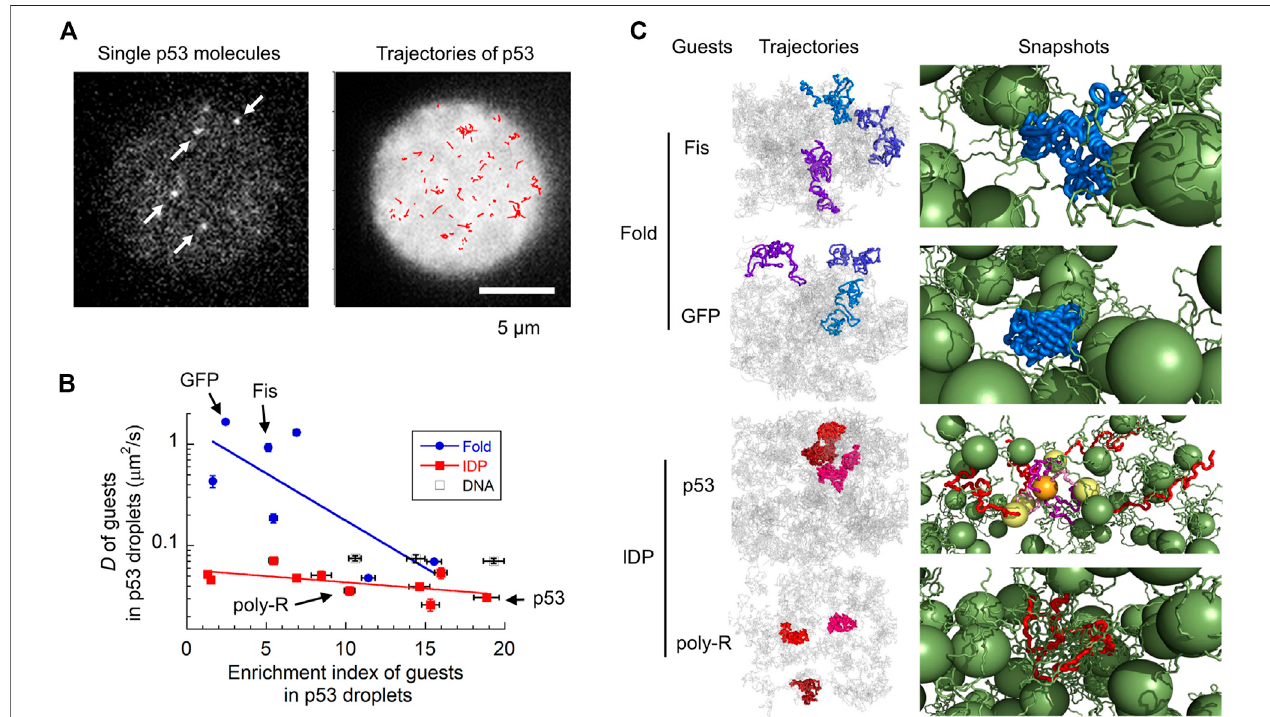
FIGURE 2 | Molecular characterization of guest proteins in p53 droplets. (A) Snapshots and trajectories of guest p53 molecules in p53 droplets detected via SM fl uorescence microscopy. The trajectories of molecules (red) in the right panel are plotted in adroplet(white). (B) Uptakepreference (enrichment index) versus dynamics (diffusion coef fi cient) of various guest proteins and DNAs in p53 droplets revealed using SM fl uorescence microscopy. The solid lines are for guiding folded proteins and IDPsusingtheeye. (C) Trajectoriesandsnapshotsoffourguestproteins(FisandGFPasfoldedproteins;p53andpoly-RasIDPs)inp53dropletsincoarse-grained MD simulations. In the snapshots, guest proteins are colored blue and red (as well as yellow and orange), whereas host p53 molecules are colored green. Panels (A – C) are adapted from (Kamagata et al., 2021c) with some modi fi cations.